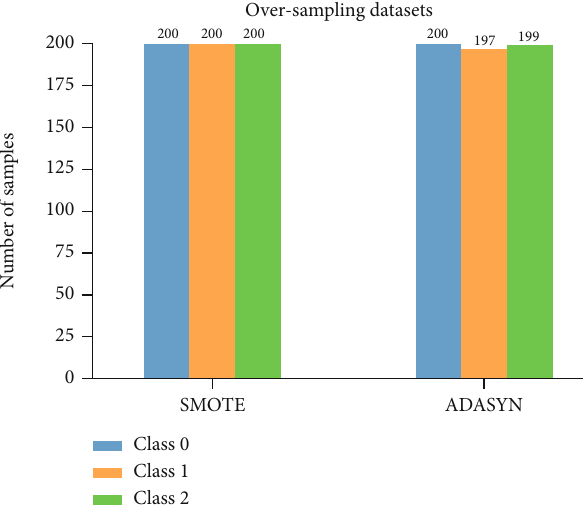
Figure 7: Number of samples per class in the datasets which undersampling TL, ENN, OSS, and CNN are applied.